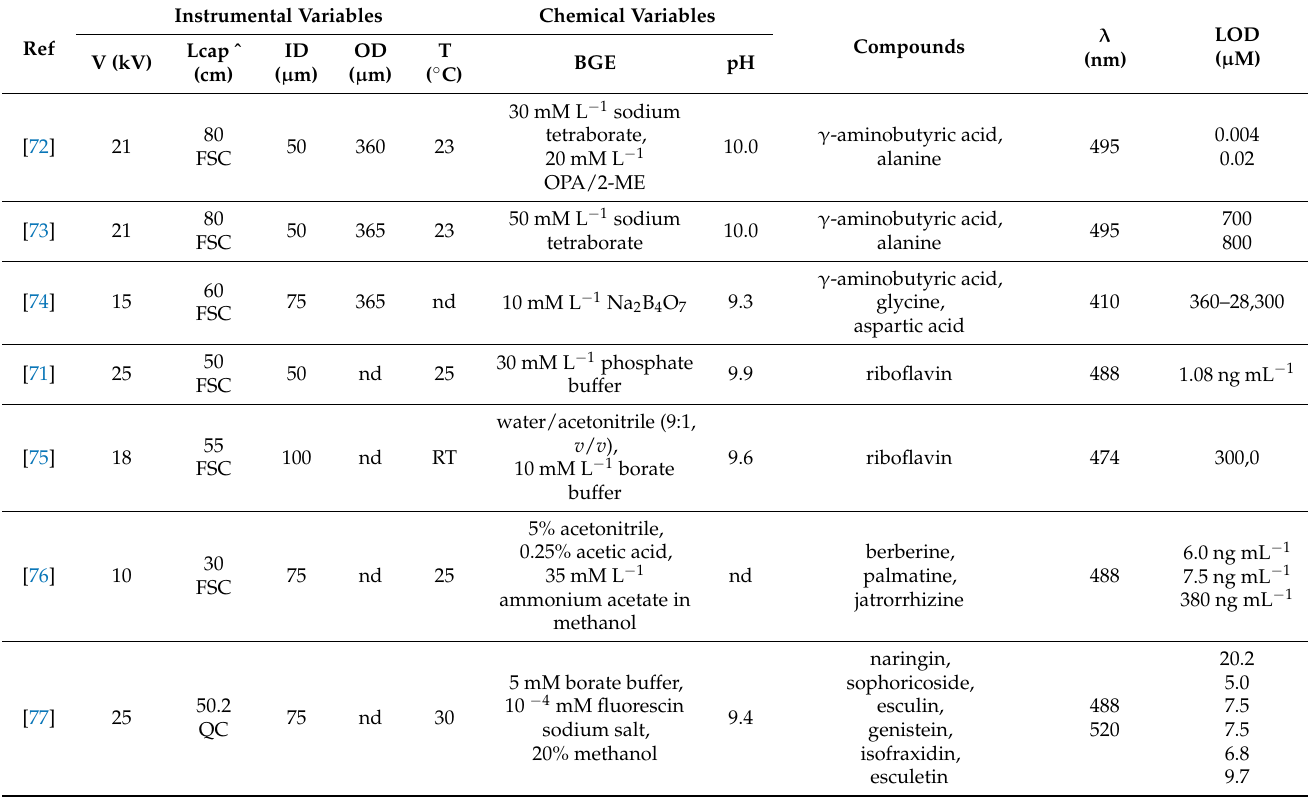
Table 4. Application of capillary electrophoresis with fluorescence